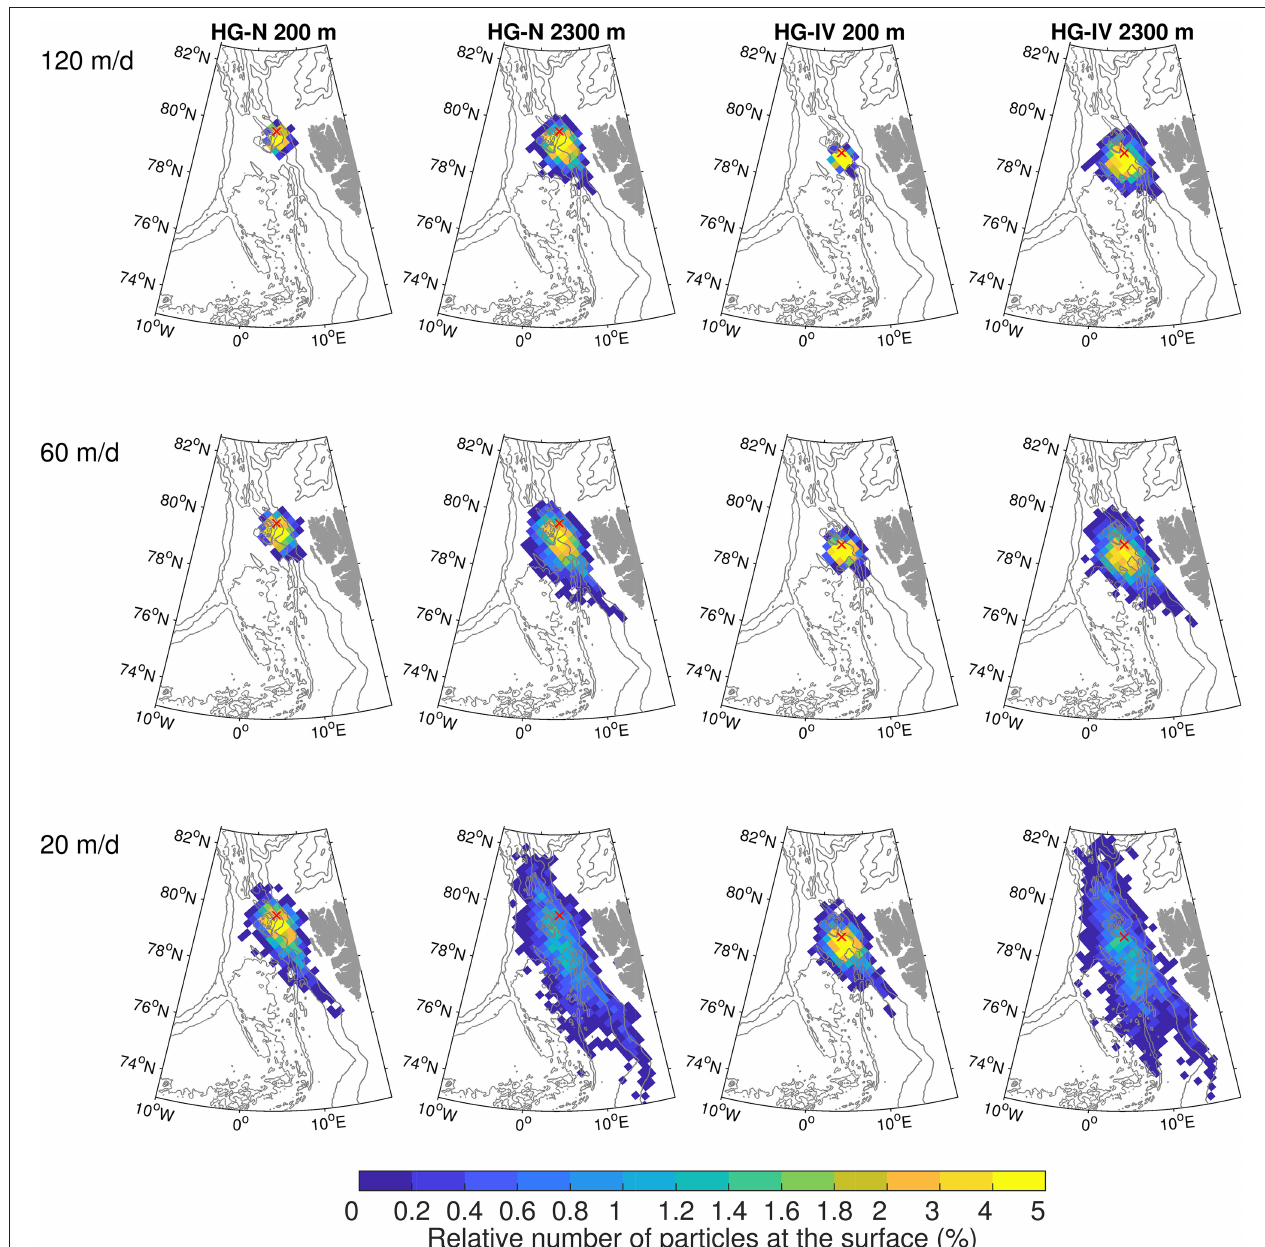
FIGURE 2 | Relative number of particles (in %) reaching the surface in bins of 24 × 24 km size, originating from moorings HG-N and HG-IV at 200 and 2,300 m depth and assuming different settling velocities (120 , 60, and 20 m/d). Particle positions at the sea surface are binned into the spatial grid and then divided by the total number of particles. The red cross indicates the mooring location. Gray contours show the bathymetry at 1,000 m